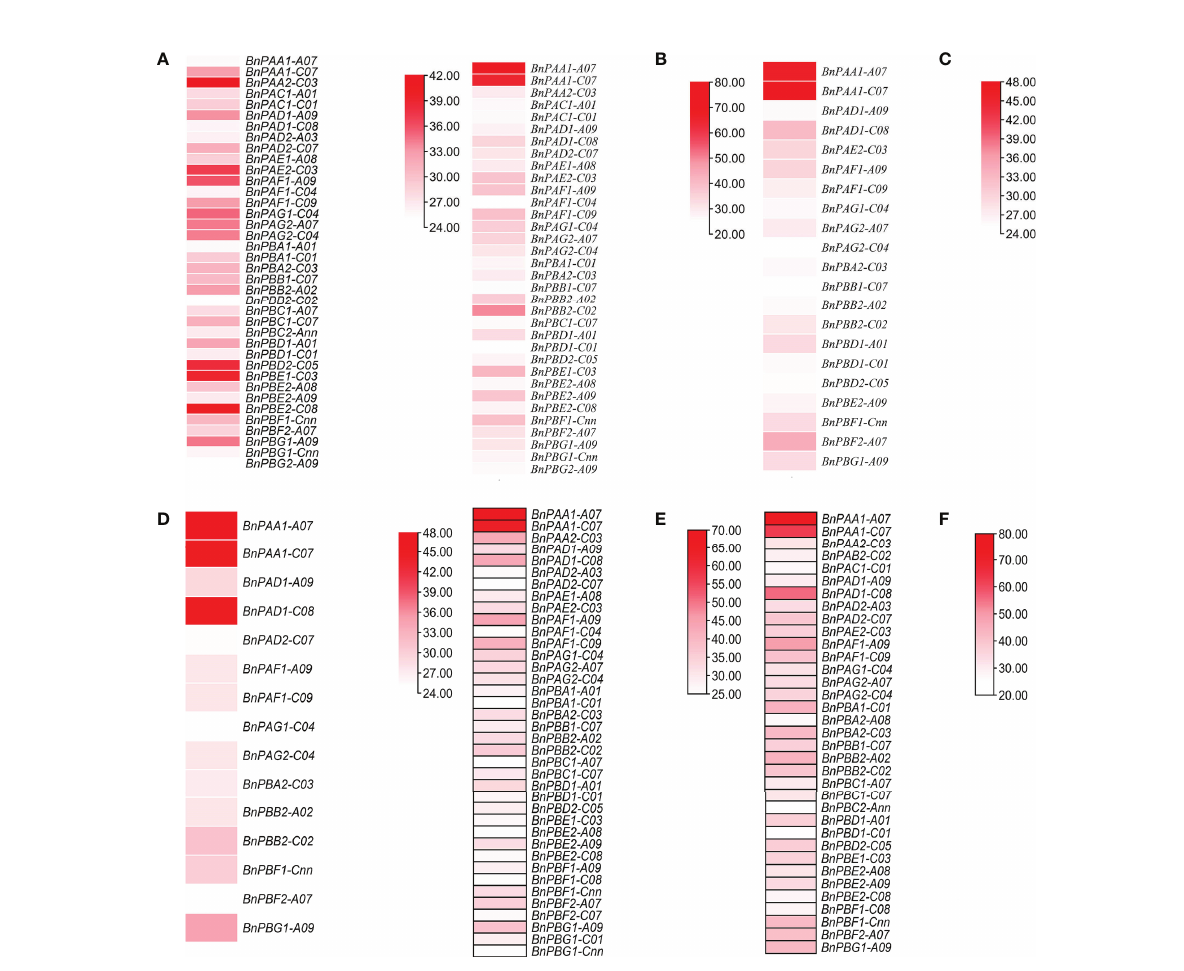
FIGURE 4 Expression pro fi le of BnPA and BnPB genes at two developmental stages in six different tissues, (A) germination (cotyledon), (B) germination (seed), (C) germination (hypocotyl), (D) seedling (leaf), (E) germination (radicle) and (F) seedling (root), under normal conditions in B. napus . The expression data are represented in the form of FPKM